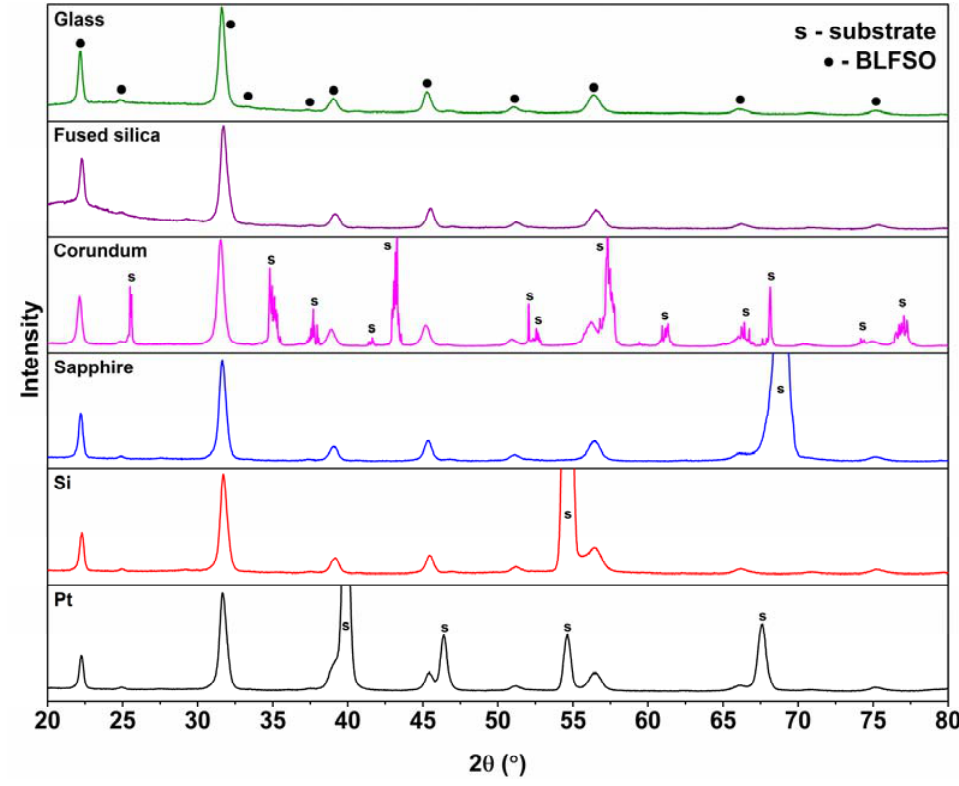
Figure 3. XRD patterns of the BLFSO films processed at 600 ◦ C on different substrates. It is well known that high annealing temperatures may lead to the formation of dense, well-crystallized films. However, the limitations caused by the metastable nature of bulk BLFSO do not suggest high-temperature processing. For this reason, some of the synthesized films were additionally annealed at different temperatures in order to determine the limiting annealing conditions. The XRD patterns of BLFSO films deposited